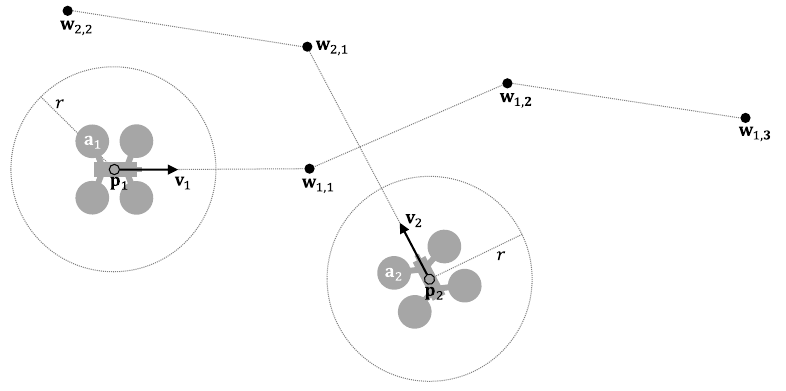
Figure 1. Two UAVs in the airspace.